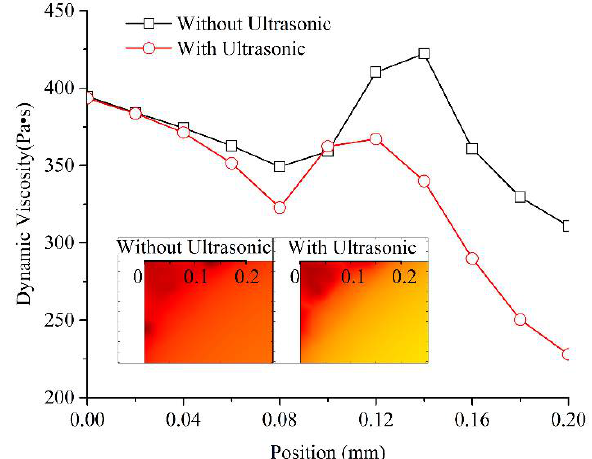
Figure 5. The melt viscosity distribution in the corner region with and without the effect of ultrasonic vibration.